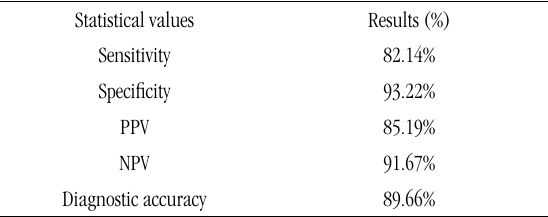
tABLE 4 – Statistical values: diagnostic accuracy between FNA